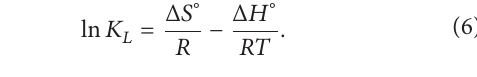
(mg L −1 ), respectively.